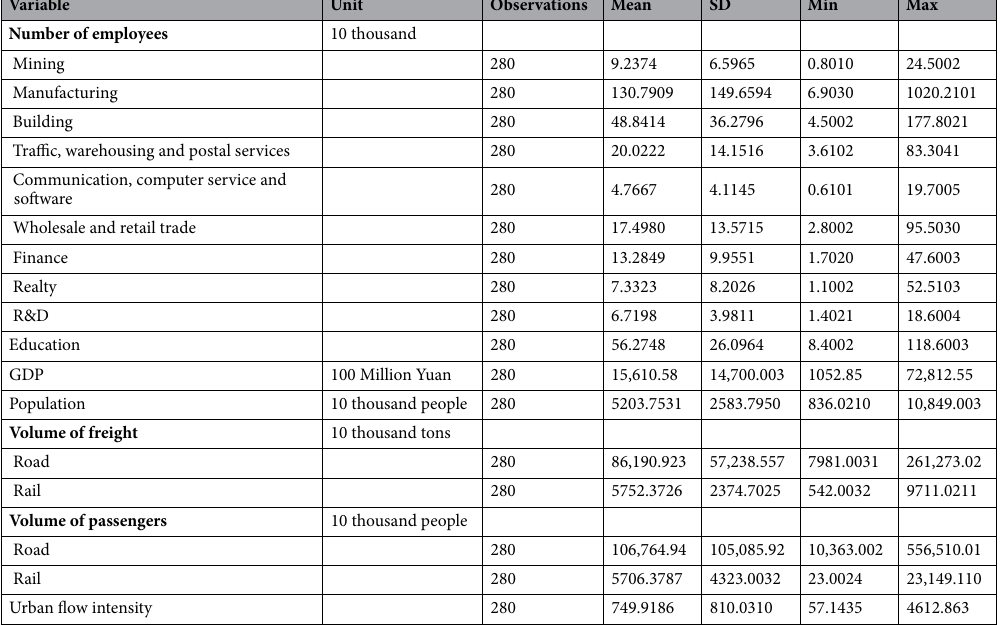
Table 1. Descriptive statistics of the variables.